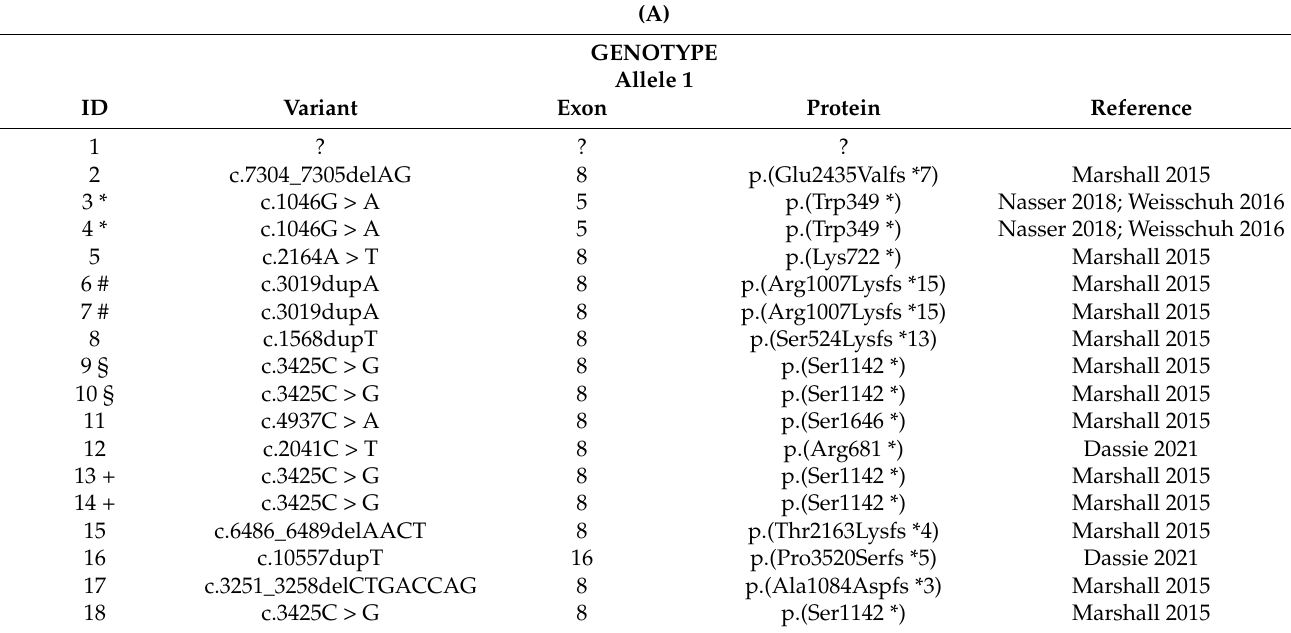
Table 2. Description of ALMS1 pathogenic variants in patients with ALMS. Pathogenic variants of ALMS1 identified by genomic sequencing were described as c.DNA variants with respect to the reference sequence NM_015120.4 according to the guidelines indicated by the Human Genome Variation Society (HGVS) described by den Dunnen et al. [42] and were validated using VariantValidator.org_v0.1.3